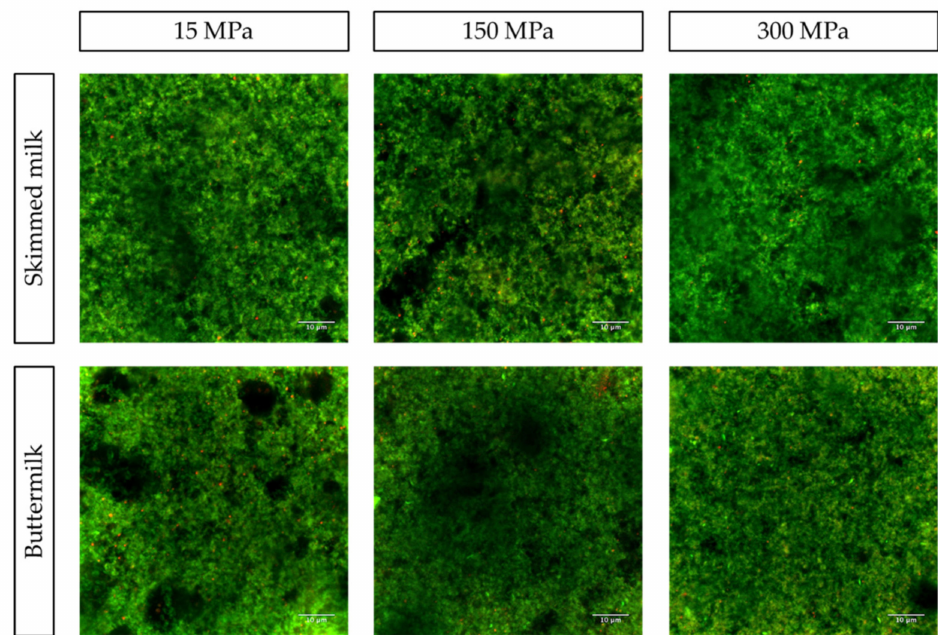
Figure 6. Confocal laser scanning microscopy (CLSM) images of stirred skimmed milk (SM) and buttermilk (BM) yogurts with different pressure applications (15, 150, and 300 MPa). The red color represents the phospholipids (PLs) labeled with Nile Red; the green color represents the milk proteins labeled with Fast Green FCF. Scale bar (10 µ